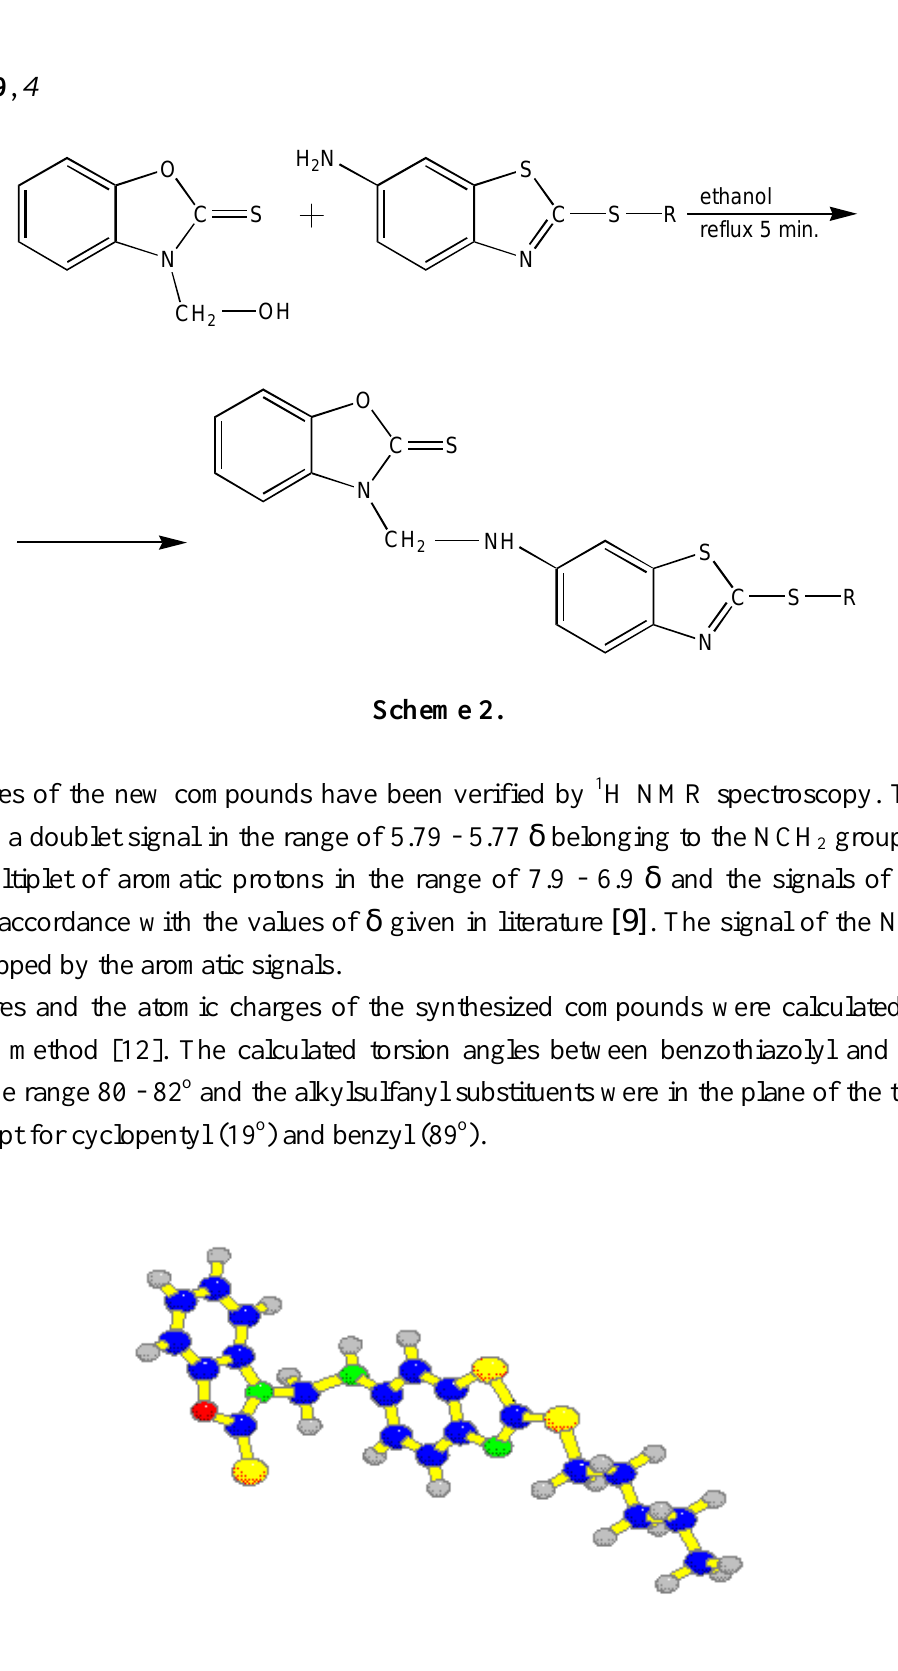
Figure 1. Scheme of the most active compound ( 7 , R = - (CH